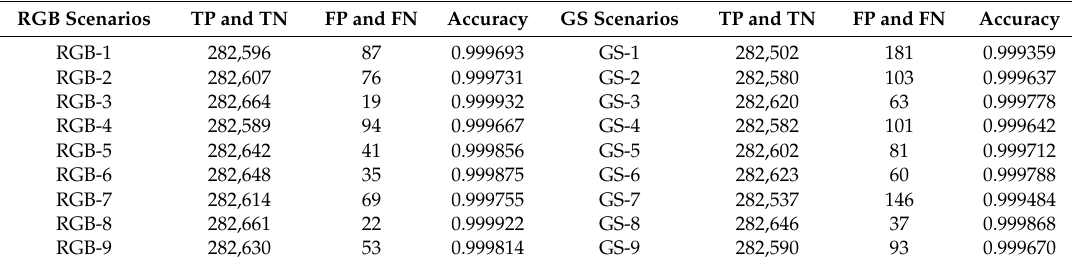
Table 5. Experimental results of 18 scenarios for KDD.